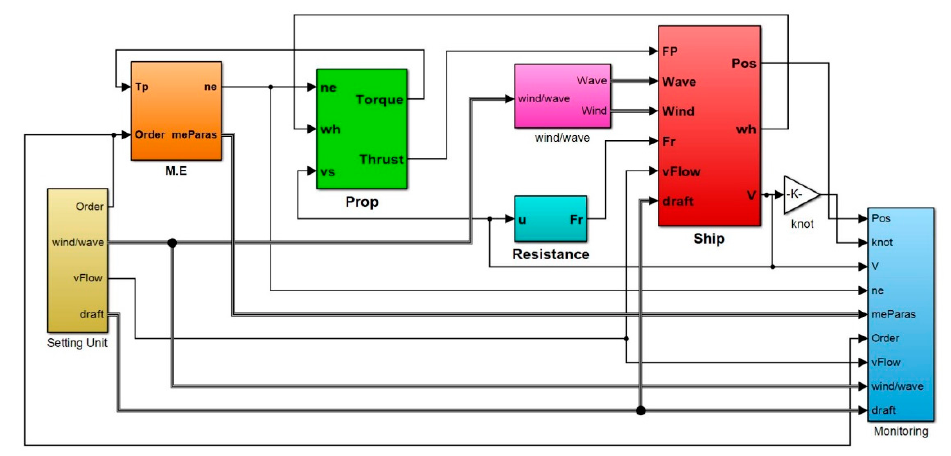
8 of 17 Figure 7. The training parameter curve. ( a )Gradient ( b )Mu (c) validation fail. The BP neural network parameters after training were shown in Appendix A.2 Section. 3. Ship Propulsion Model